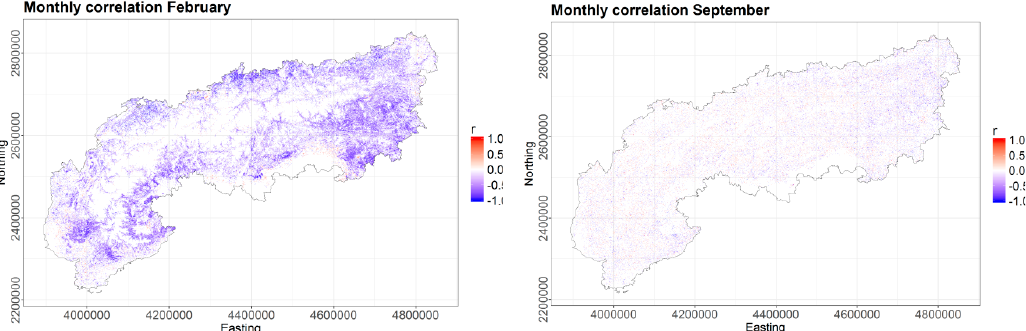
Figure 11 . Spatial representation of significantly positively (red) and negatively (blue) correlated SCD and NDVI in February ( left ) and September ( right ).